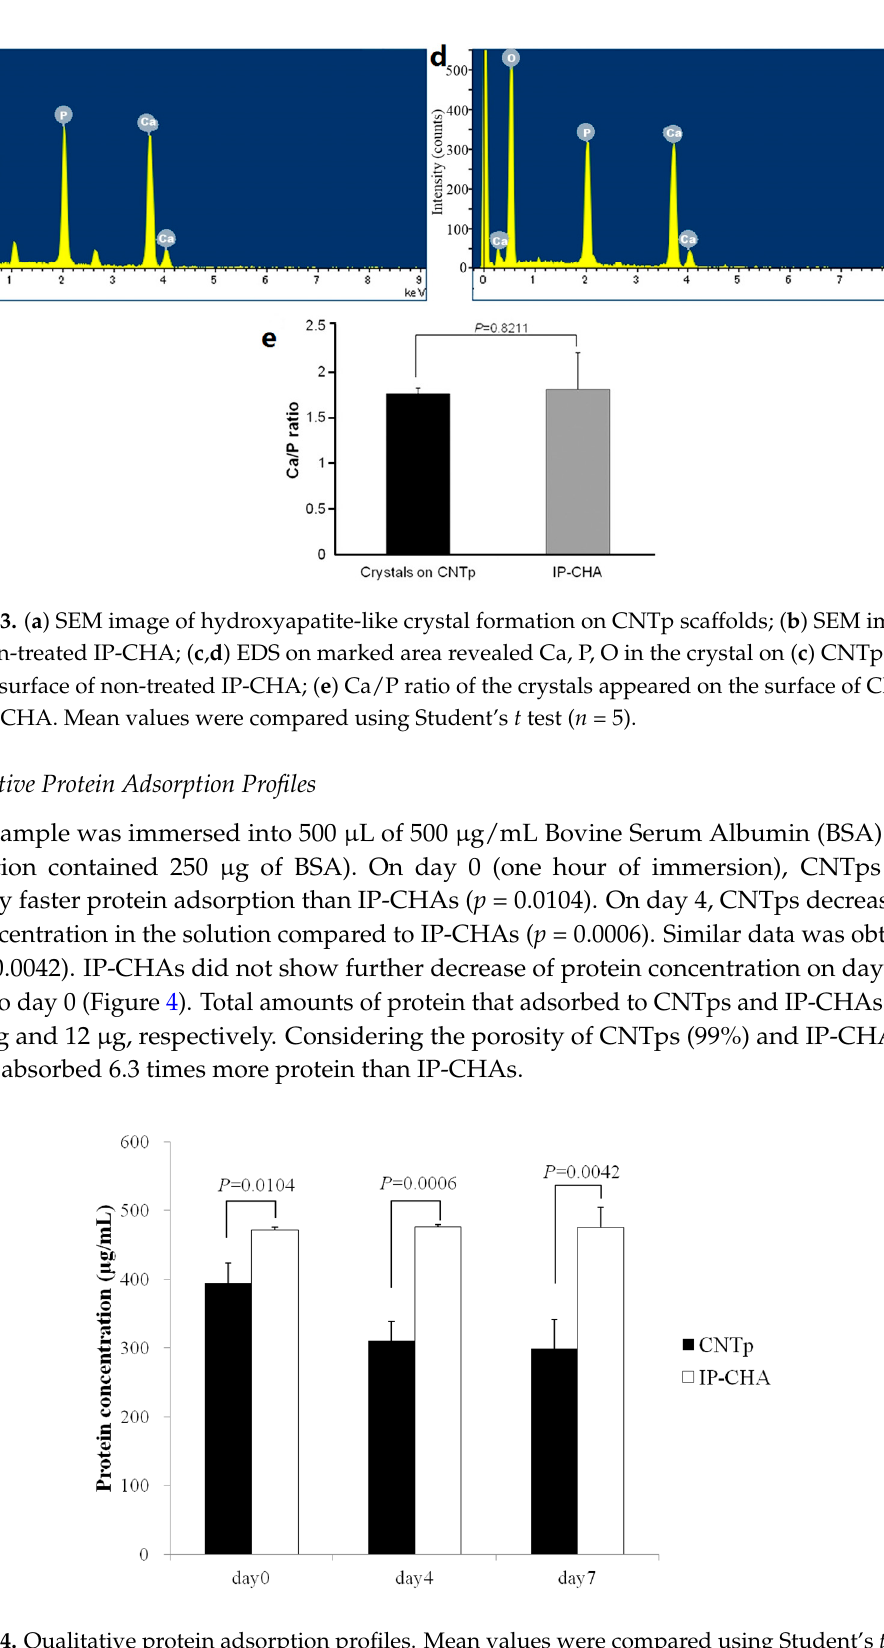
Figure 4. Qualitative protein adsorption profiles. Mean values were compared using Student’s t test ( n = 3).